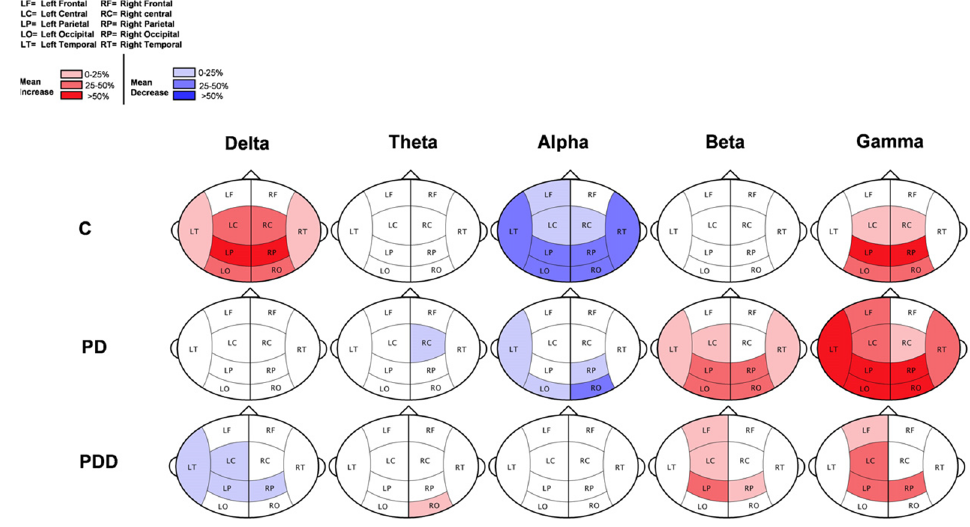
Figure 9. Schematic representation of results of the comparison between the eyes open and the eyes closed condition (PDD-—Parkinson’s disease-related dementia; PD–Parkinson’s disease without dementia; C—healthy, elderly controls. Reprinted from [107]. (Copyright 2006 Elsevier) Image reproduced with copyright permission.